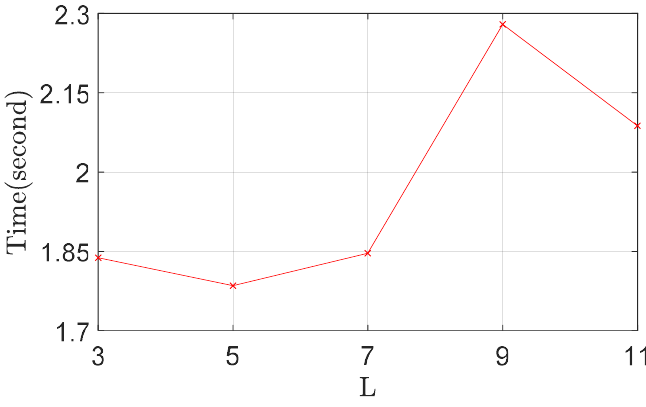
Figure 9. The e ff ect of L on the detection e ffi ciency. Figure 9. The effect of L on the detection efficiency.